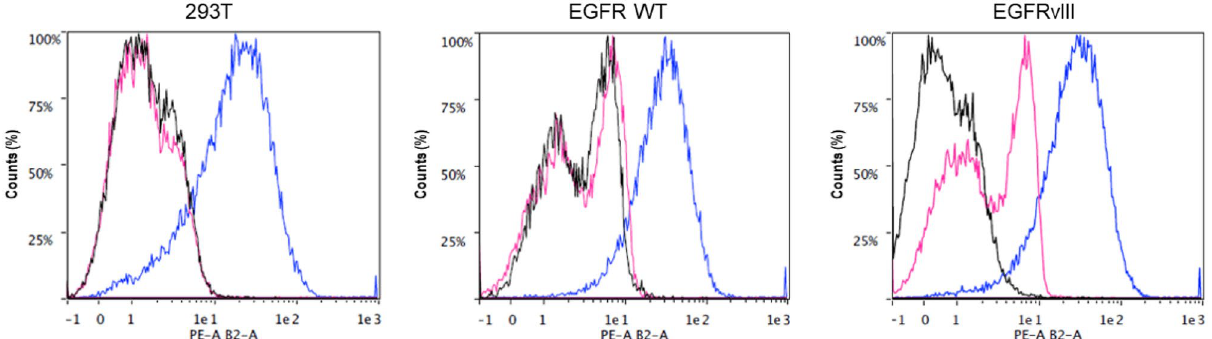
Figure 3. VLGREEWSTSYW-M13 binding analysis by flow cytometry. 293T, EGFR WT and EGFRvIII cell lines were incubated with the VLGREEWSTSYW-M13 phage-displayed peptide. Cell counts in % versus PE signal: when incubated with primary + secondary antibody (anti-M13_biotin + anti-biotin_PE, pink), isotype labelling + secondary antibody (anti-IgG3_biotin + anti-biotin_PE, blue) or secondary-only antibody (anti- biotin_PE,